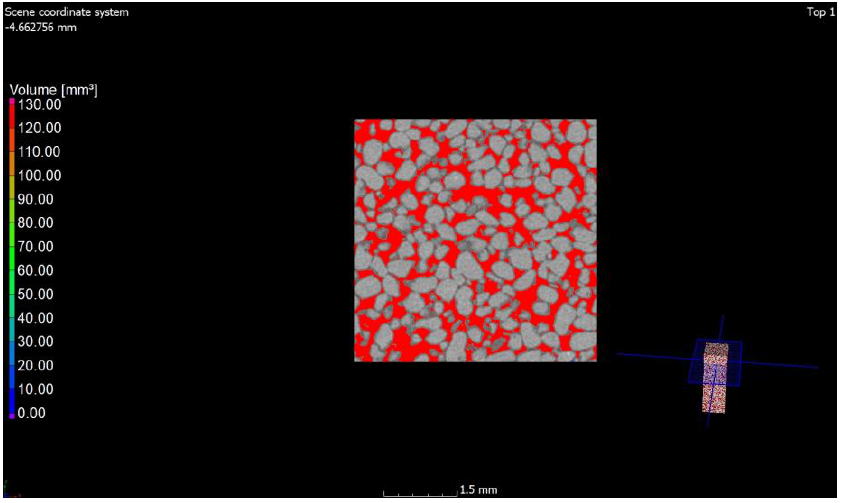
Figure 7. Cross-section of a sample in traditional brick. Red spots are visible free spaces that were formed at the interface between SiO 2 and CaO grains and after the hydration and autoclaving process.